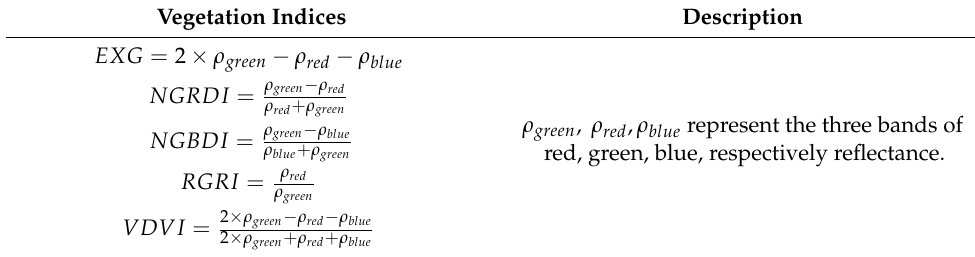
Table 4. Vegetation indices.